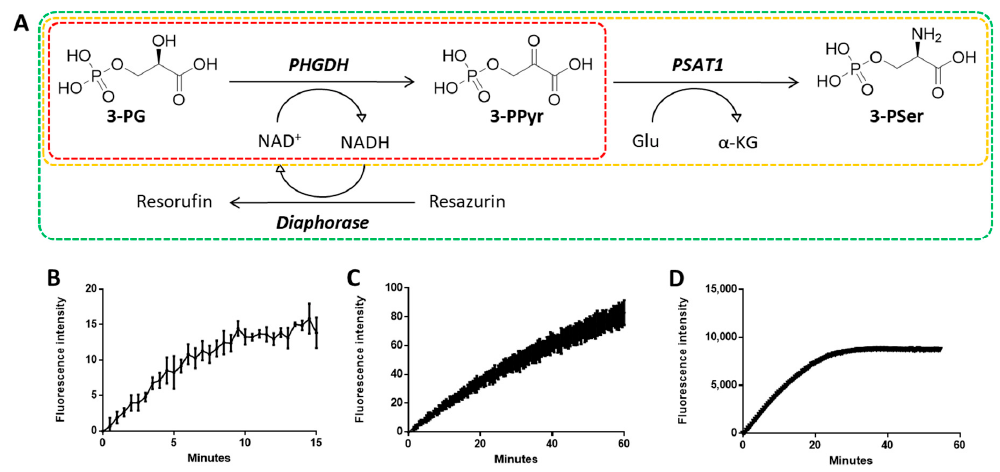
Figure 2. PHGDH coupled biochemical assay system. ( A ) Schematic representation of the coupled system. Continuous measurement of PHGDH activity for initial PHGDH assay ( B ), for PHGDH / PSAT1 coupled assay ( C ), and for present fully coupled assay ( D ). (3-PG, 3-phosphoglycerate; 3-PPyr, 3-phosphopyruvate; 3-PSer, 3-phosphoserine).